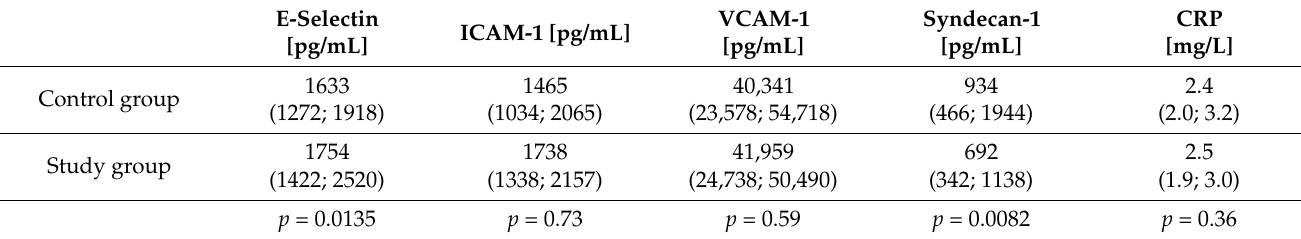
Table 2. Median concentrations of soluble adhesion molecules and CRP in the study and control groups. There were significant differences in E-selectin and syndecan-1 between the two groups.